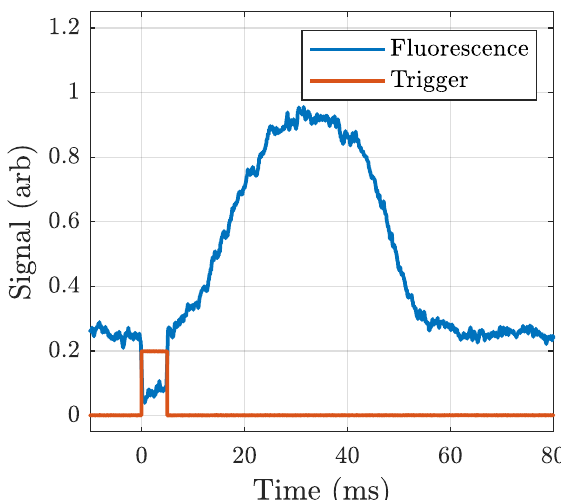
Figure 3. Time-of-flight detection signal of optically pumped atoms. The amplitude peak corresponds to the most probable speed of 6.4